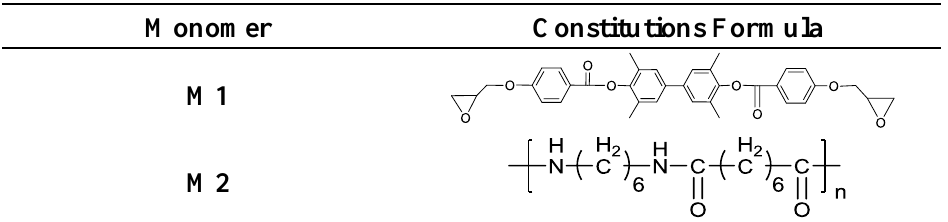
Table 1. Structure of M1 and M2 .